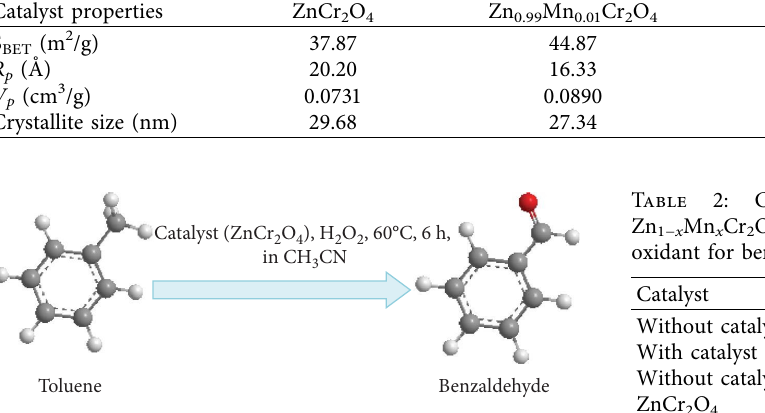
Scheme 1: Schematic representation for the oxidation of toluene with ZnCr 2 O 4